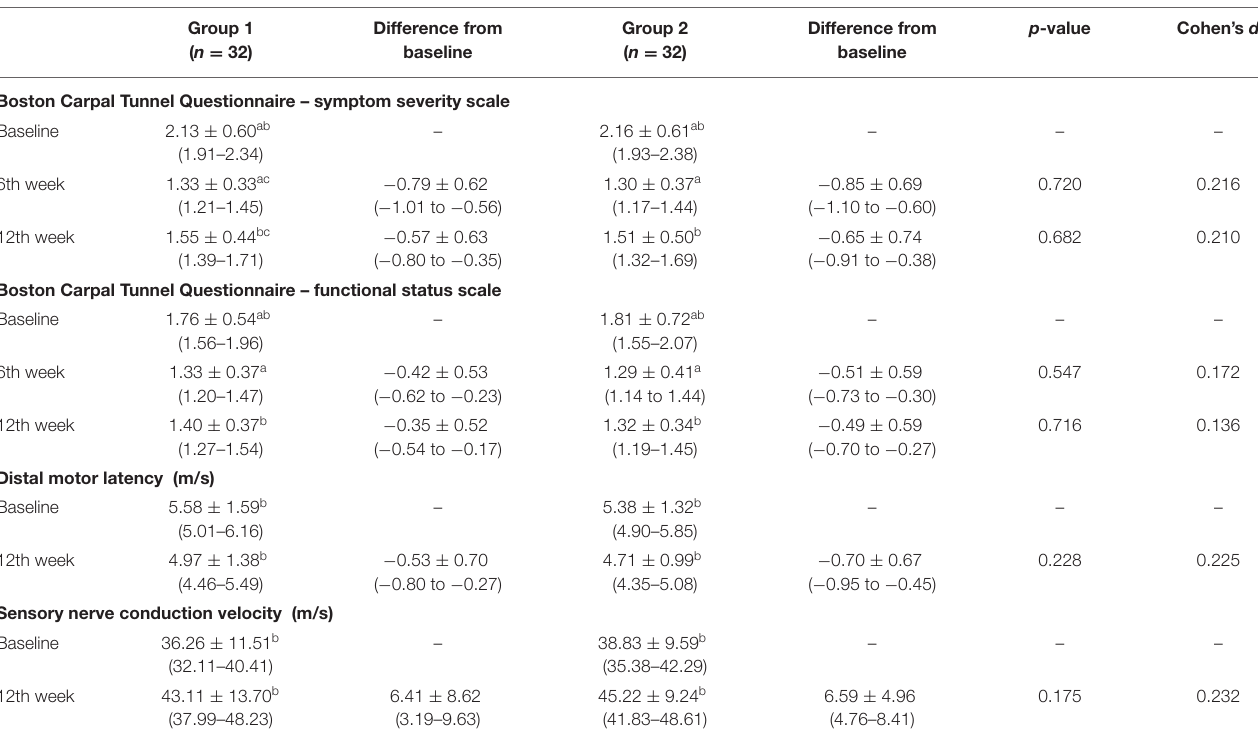
TABLE 2 | Clinical Outcomes at baseline, 6th and 12th